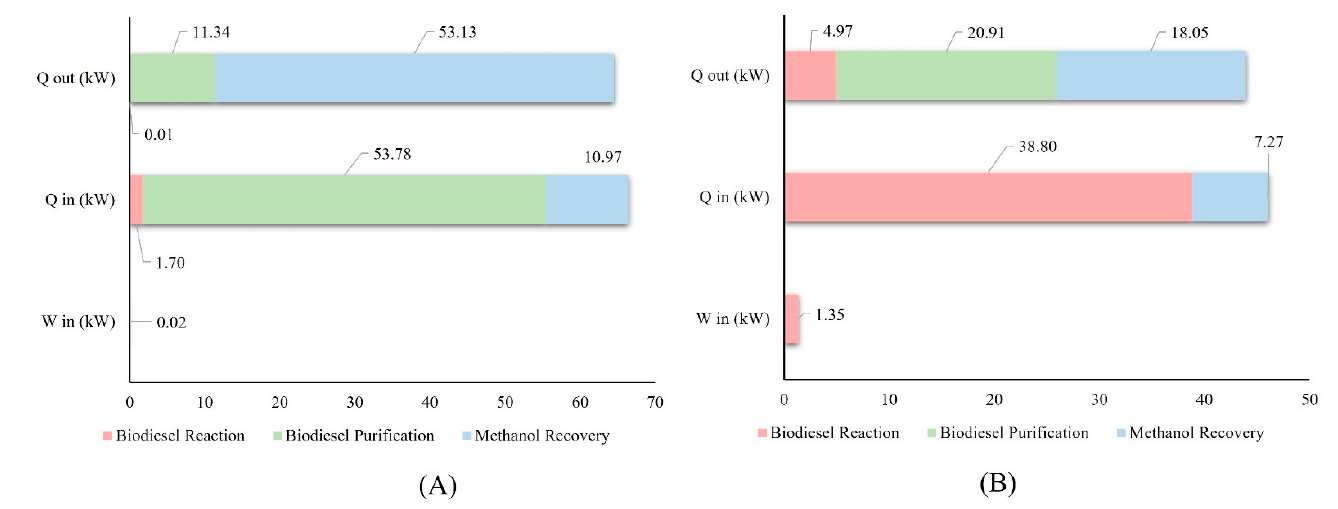
Figure 3. Energy loads of the main stages of the biodiesel production processes. ( A ) Alkaline process, ( B ) Supercritical process.